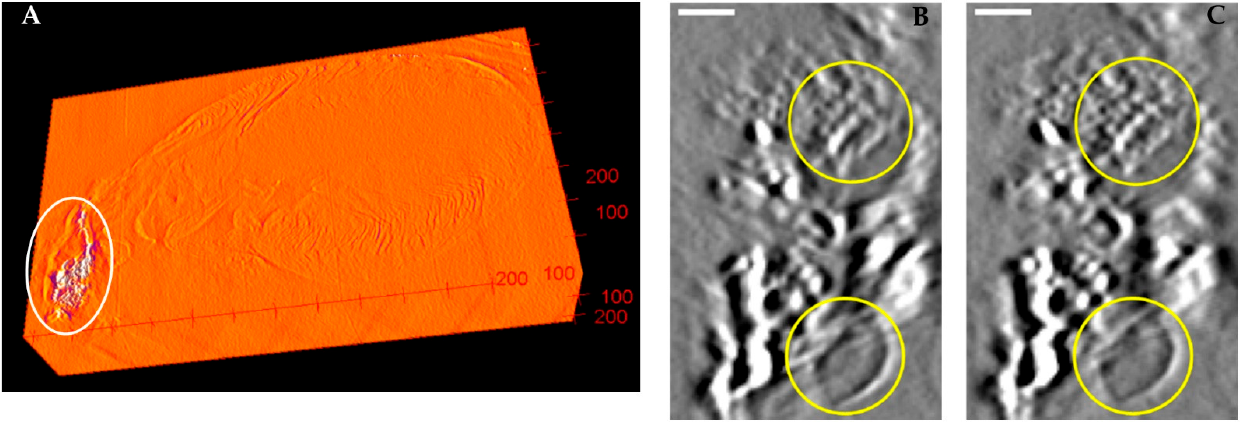
Figure 6. ( A ) is the reconstructed 3D stack of a paraffin-embedded mouse heart sample including an aorta segment. The white oval highlights a calcified lesion in the aorta. ( B , C ) are magnified views of the calcified lesion before and after applying geometric calibration. The white scale bar is equivalent to 160 µ m. The yellow circles highlight the internal grain texture of the calcification and an air